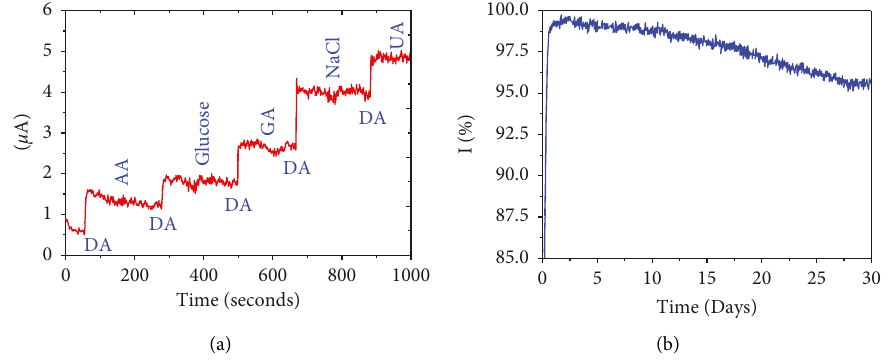
Figure 5: (a) Interference study for the detection of DA and (b) stability of the sensor